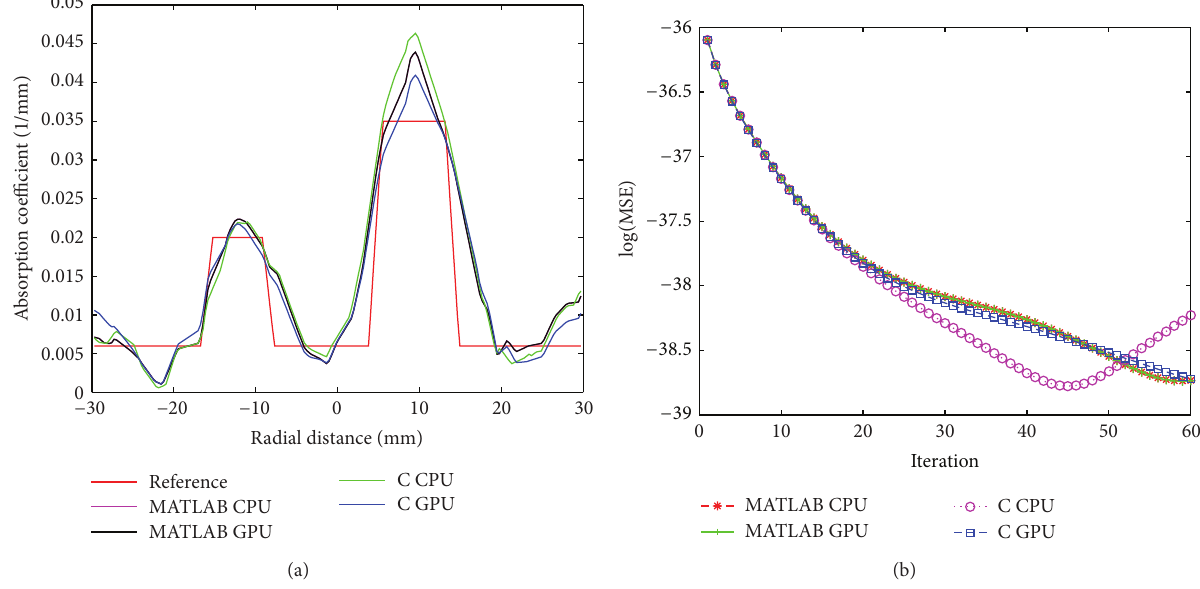
Figure 7: For experimental phantom, (a) cross-sectional line through the center of inhomogeneities 1 and 2 and (b) MSE between computed measurements and the experimental measurement data as iteration proceeds ( 𝑀 𝐶 and 𝑀 𝐸 ).